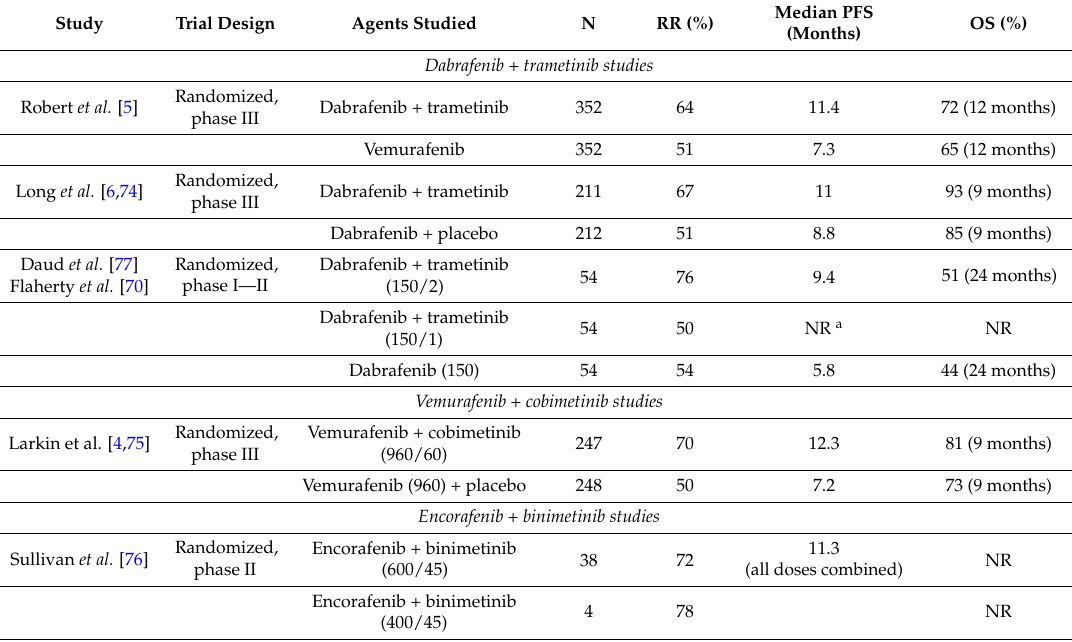
Table 1. BRAF + MEK combination